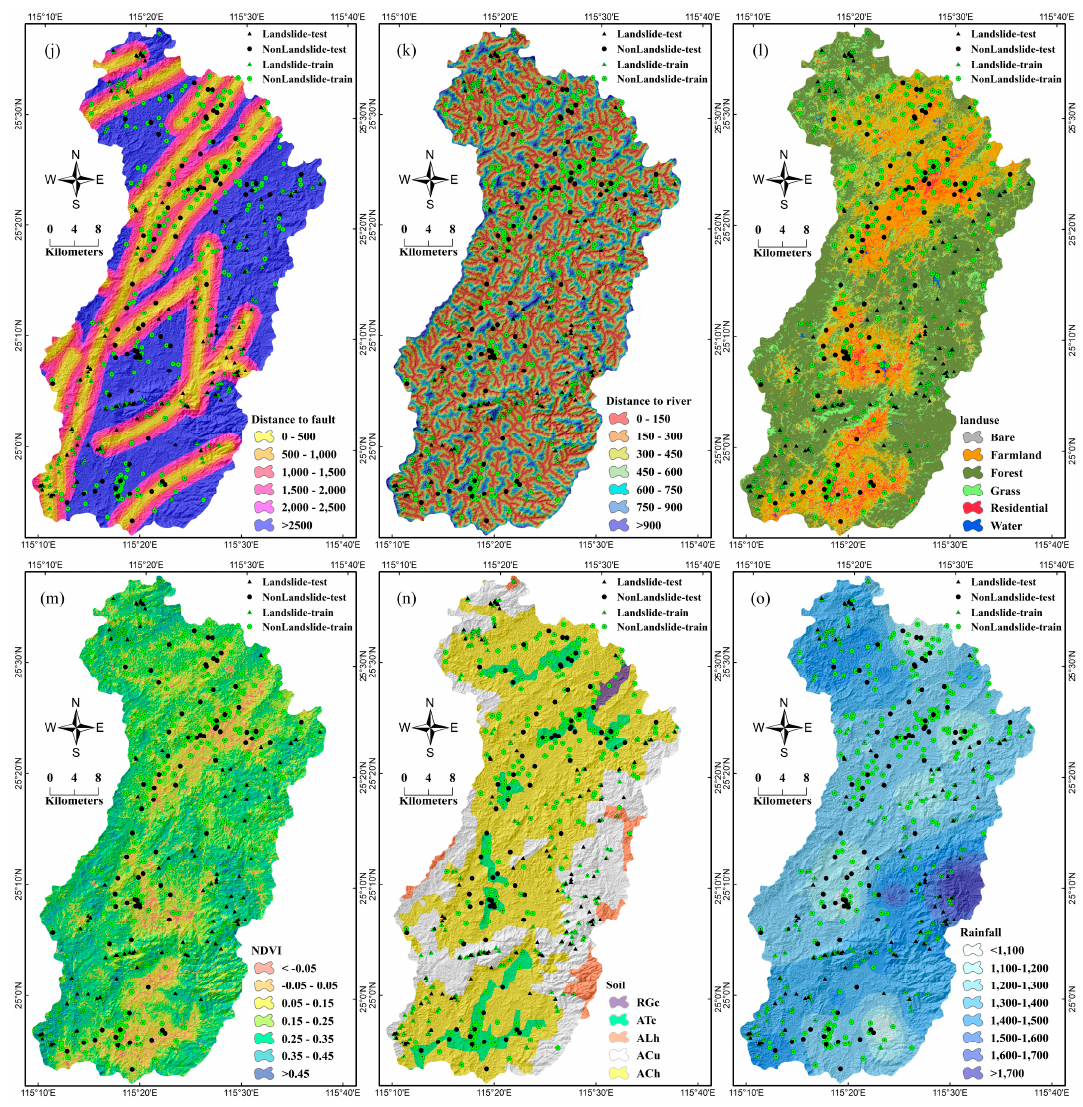
Figure 3. Landslide influencing factor maps. ( a ) Altitude, ( b ) slope, ( c ) aspect, ( d ) plan curvature, ( e ) profile curvature, ( f ) SPI, ( g ) STI, ( h ) TWI, ( i ) lithology, ( j ) distance to fault, ( k ) distance to river, ( l ) land use, ( m ) NDVI, ( n ) soil and ( o ) rainfall.